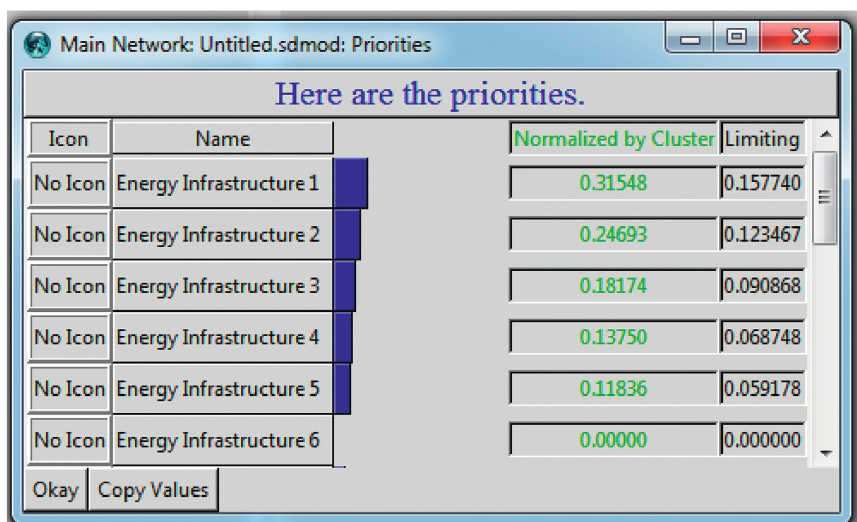
Figure 5: Ranking of the available alternatives.